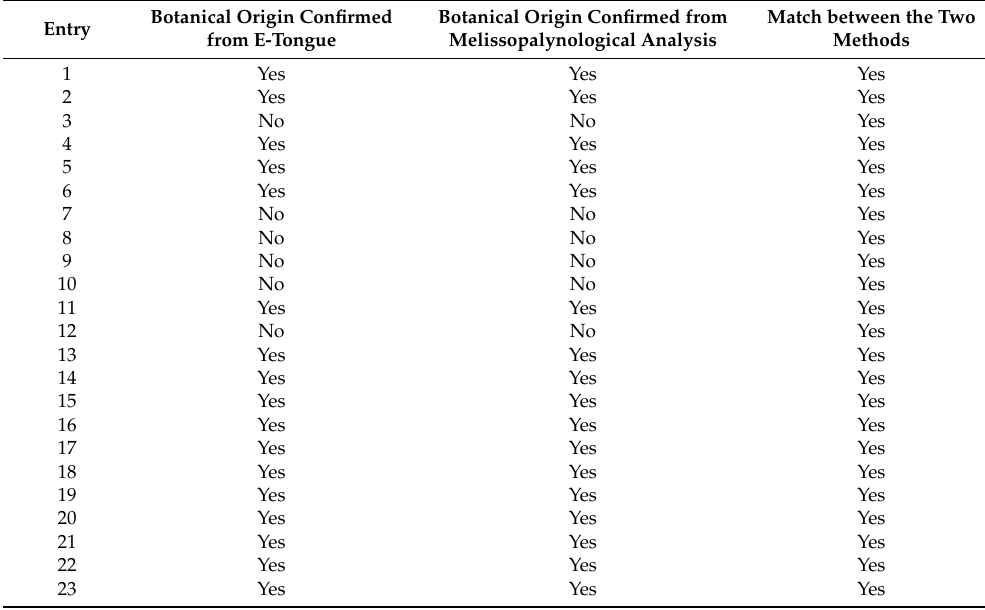
Table 3. Comparison of the results from E-tongue and melissopalynological analysis. Botanical Origin Confirmed Botanical Origin Confirmed from Entry from E-Tongue Melissopalynological Analysis